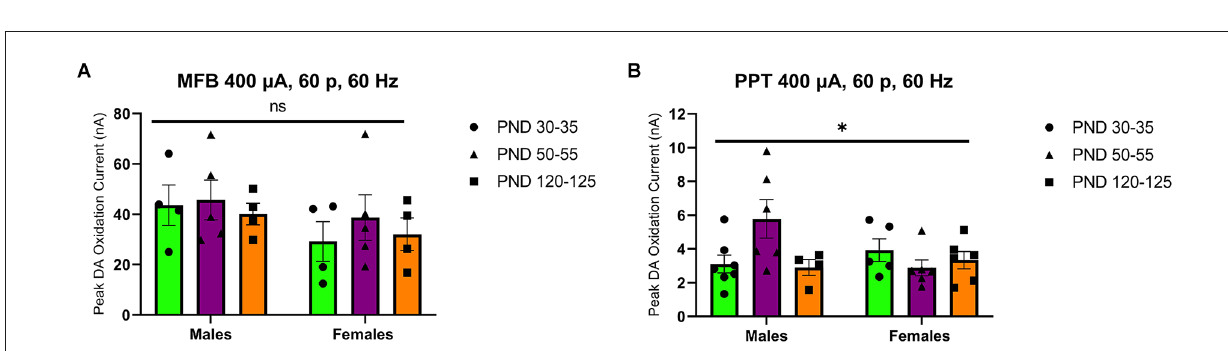
FIGURE3 Peak DA oxidation current (nA) recordings in the NAcc for electrical 60-pulse stimulation (60 Hz, 400 µ A) of the MFB (A) or PPT (B) . The pattern of NAcc dopamine release across development did not significantly differ between sexes ( n = 13 per sex) for MFB stimulation (A) but was significant between females ( n = 14) and males ( n = 14) following PPT stimulation (B) . All data are presented as mean ± SEM. ∗ p < 0.05 and ns p > 0.05 (sex × age interaction).